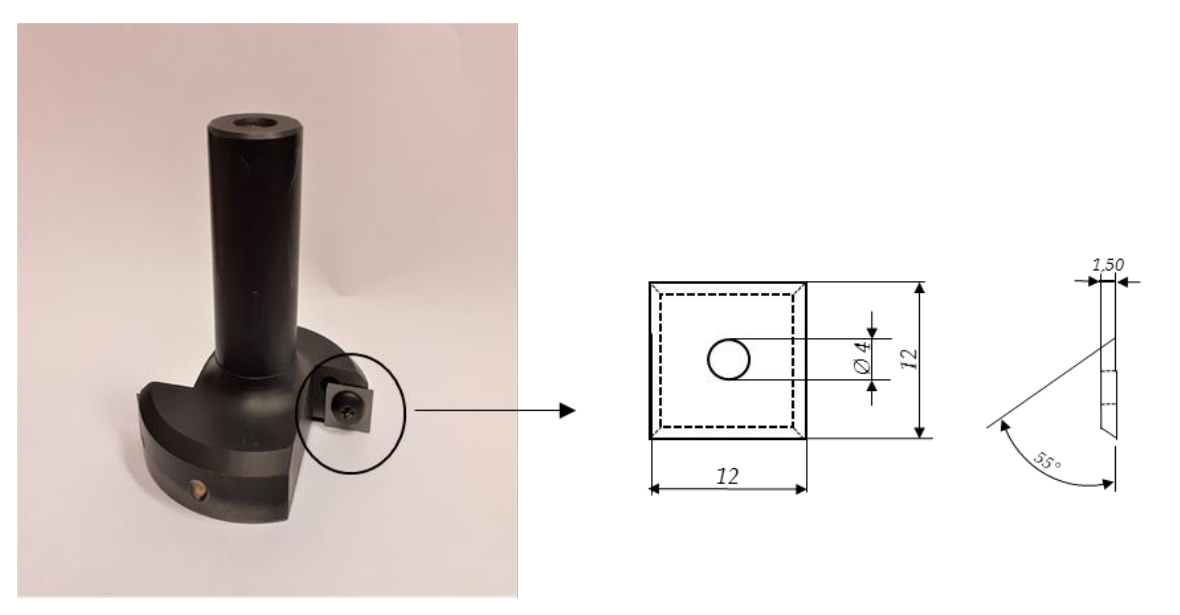
Table 1. Selected properties of the tested three-layer chipboard. Figure 3. Two-blade cutter. Figure 3. Two-blade cutter.